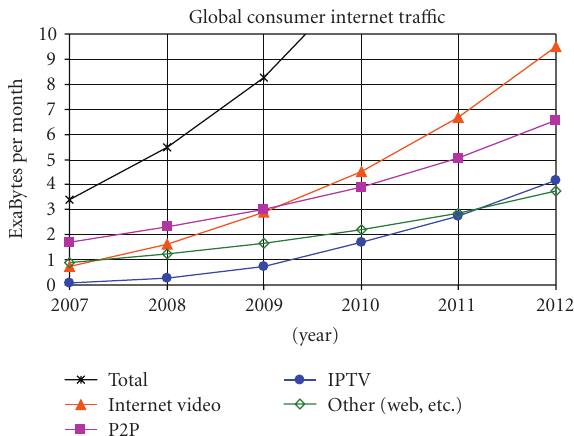
Figure 2: Cisco [13] forecasts of Global Consumer Internet Growth. One ExaByte = 10 18